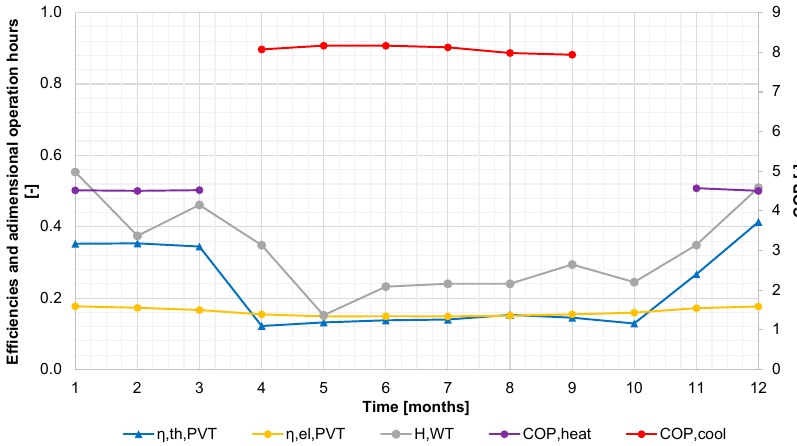
Figure 11. Energy e ffi ciency parameters of the system, monthly Figure 11. Energy efficiency parameters of the system, monthly analysis.